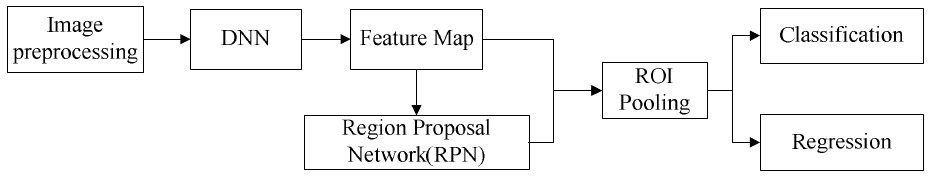
Figure 4. Faster R-CNN algorithm structure.